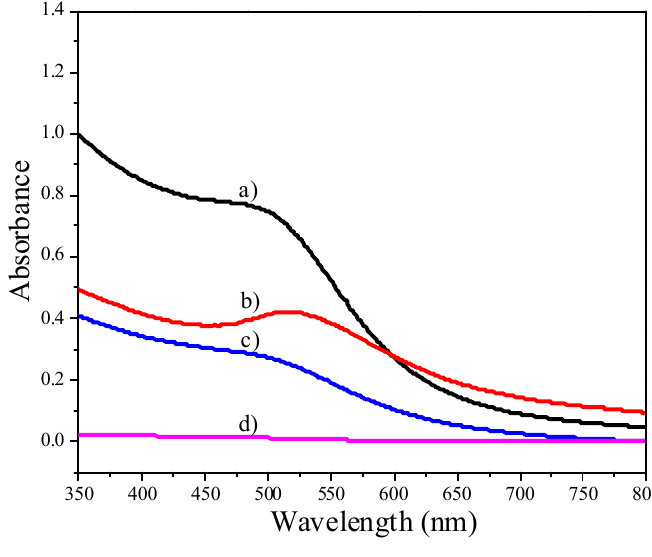
; (c) the supernatant collected after adsorbing 5.7 nm 4 O ; (d) the supernatant collected after adsorbing 5.7 nm Au 2 3 O 2 3